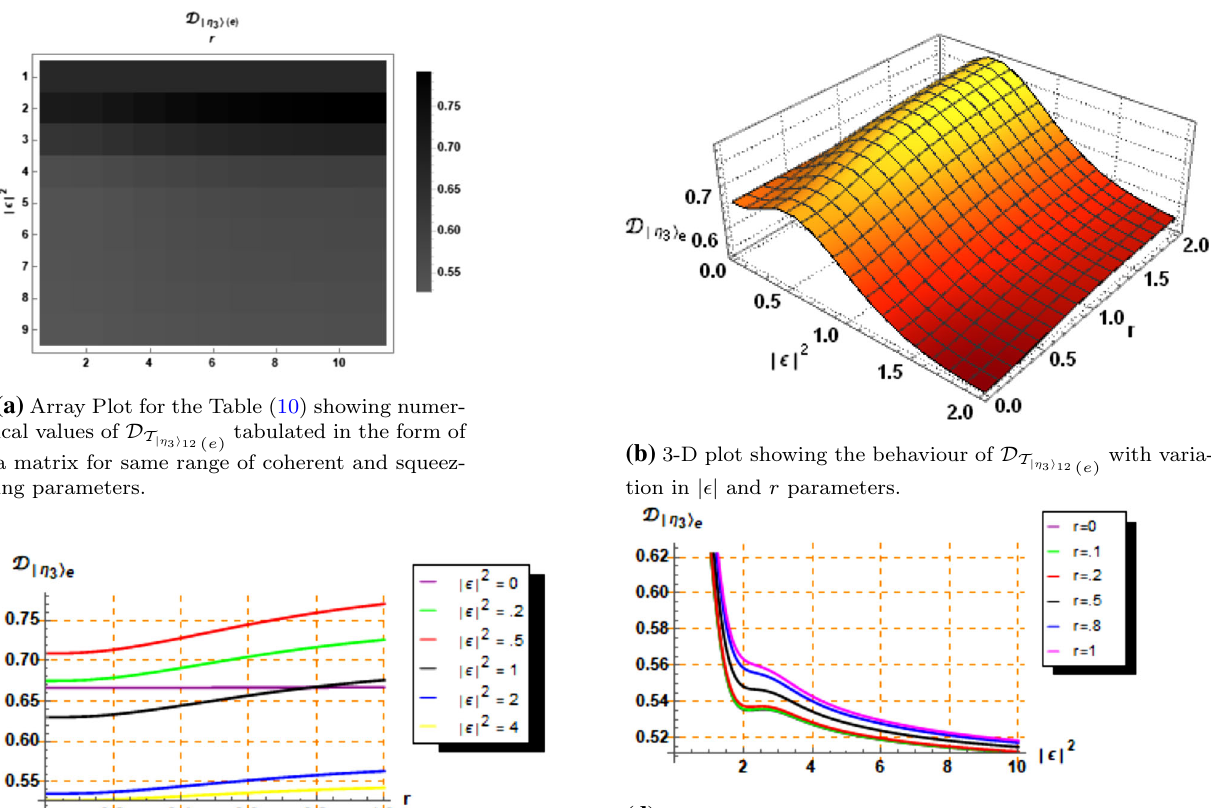
(b) 3-D plot showing the behaviour of tion in | (cid:2) | and r parameters.